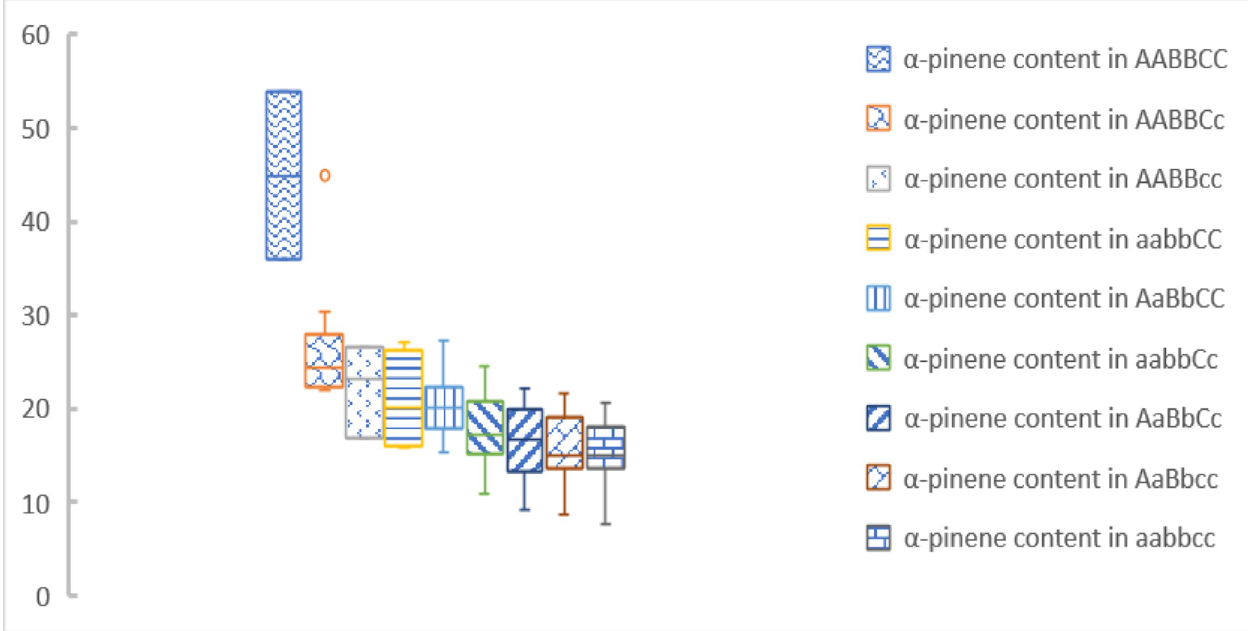
PLOS ONE | https://doi.org/10.1371/journal.pone.0266503 May 27,